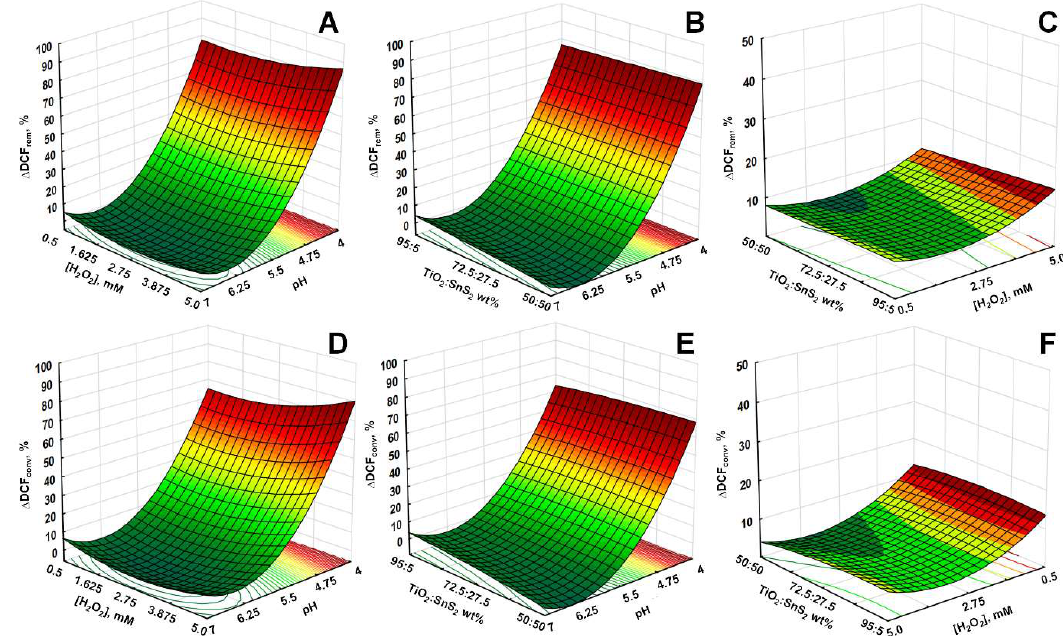
Figure 7. 3D response surface and contour diagrams showing the effects of the mutual interactions of initial pH and SnS 2 wt % on DCF removal ( A ) and conversion ( B ) by solar/TiO 2 -SnS 2 -COMM.